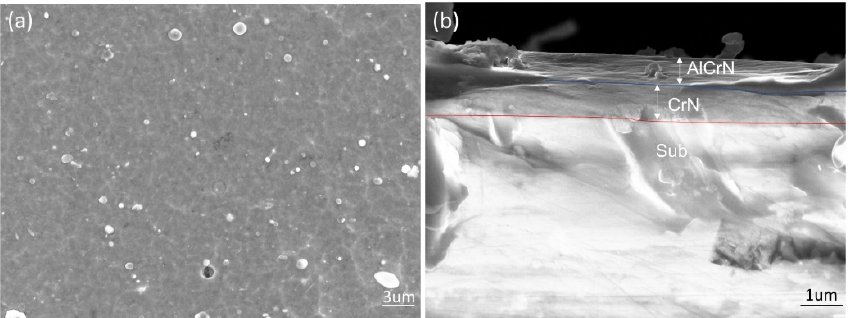
Figure 4. Coating microscopic morphology:( a ) Surface appearance; ( b ) Cross ‐ sectional shape.